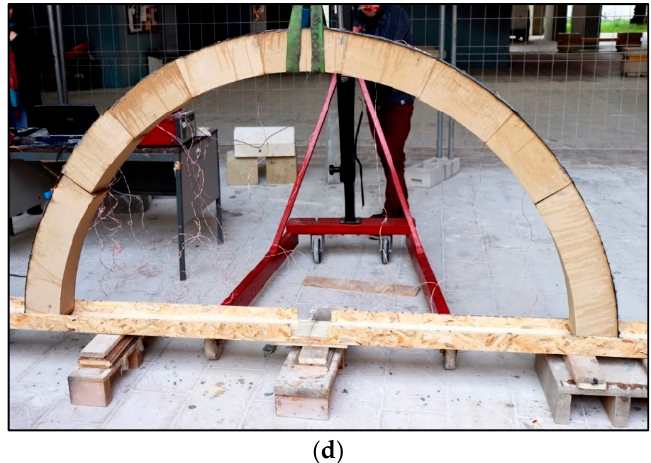
Figure 11. Progress of the lifting: ( a ) 3 voussoirs lifted; ( b ) 5 voussoirs lifted; ( c ) lateral view and ( d ) full ‐ lifted arch.